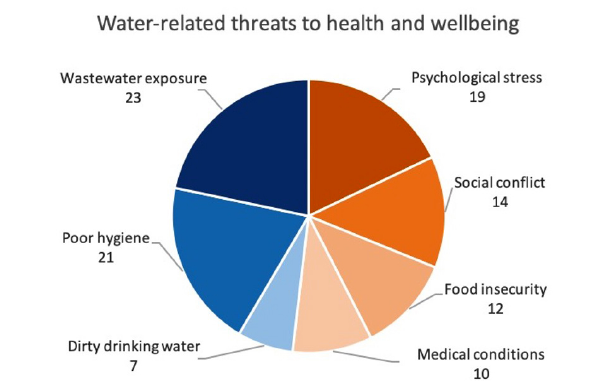
Fig. 2. The 77 stories described both direct (blue) and indirect (orange) threats to health and well-being. Several stories described more than one threat, making the sum of numbers exceed the number of